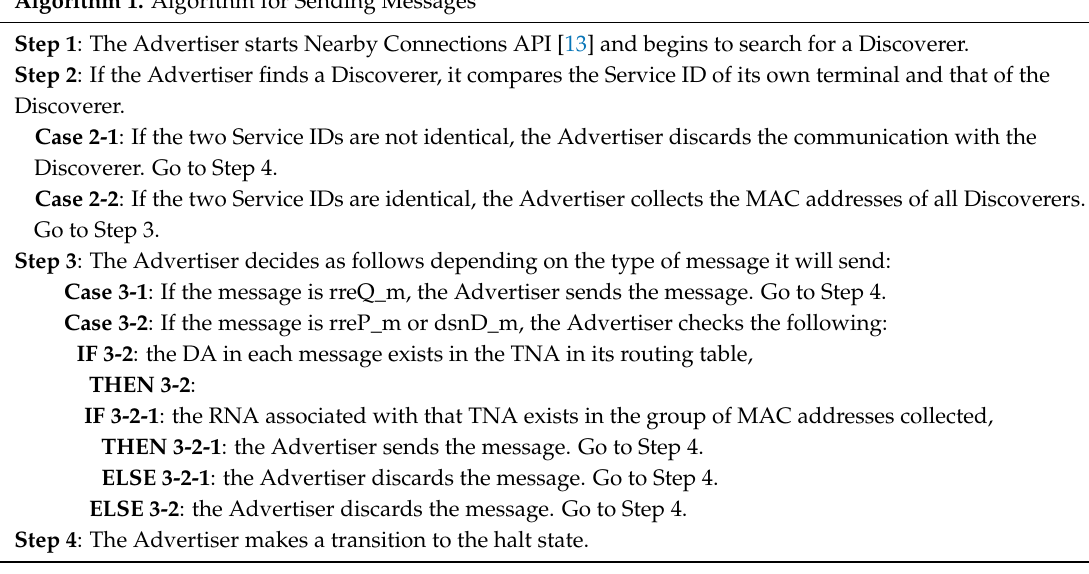
Algorithm 1. Algorithm for Sending Messages